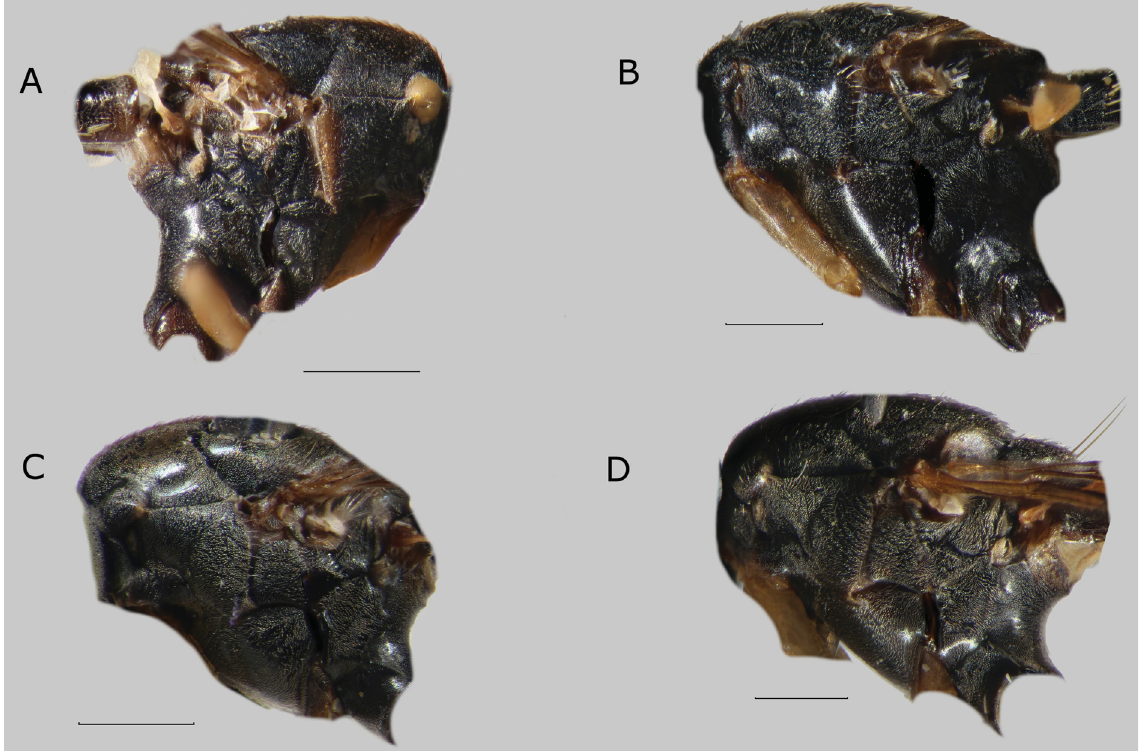
Fig. 65. Pleuron, late ral view. A . Sphegina (Asiosphegina) crinita sp. nov., holotype, ♂ , Java,